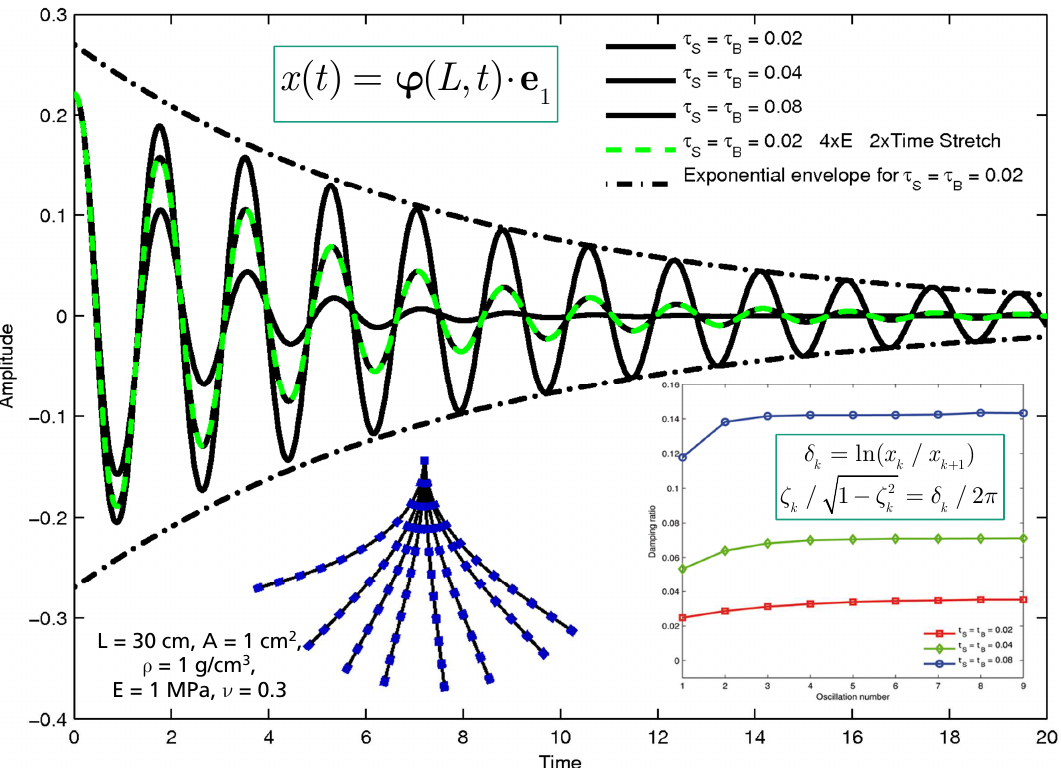
Figure 3. Damped non-linear bending vibrations of a clamped cantilever beam (see text for further details).